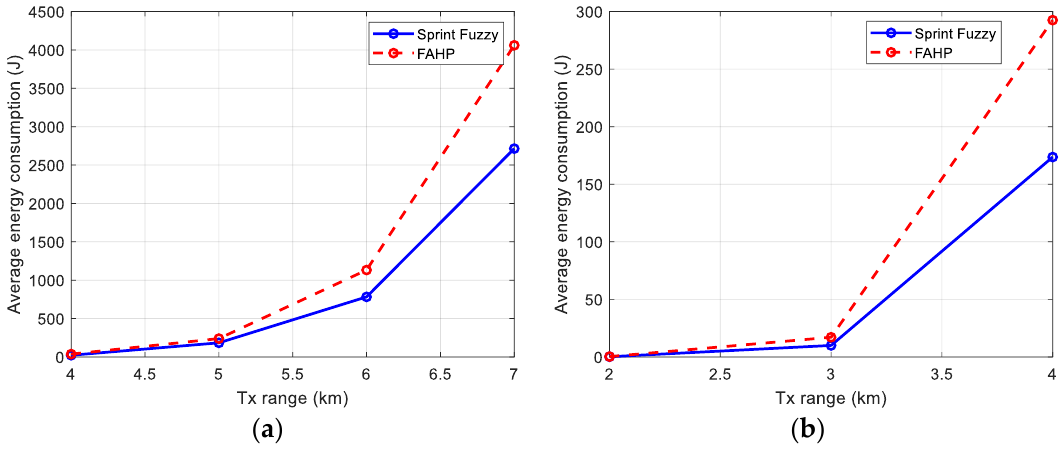
Figure 12. Average energy consumption. Number of nodes: ( a ) 100, ( b ) 400.